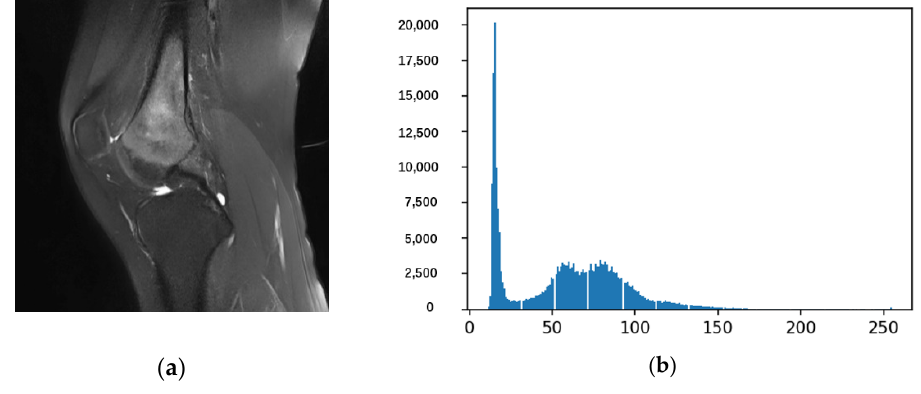
Figure 5. The frequency distribution histogram.